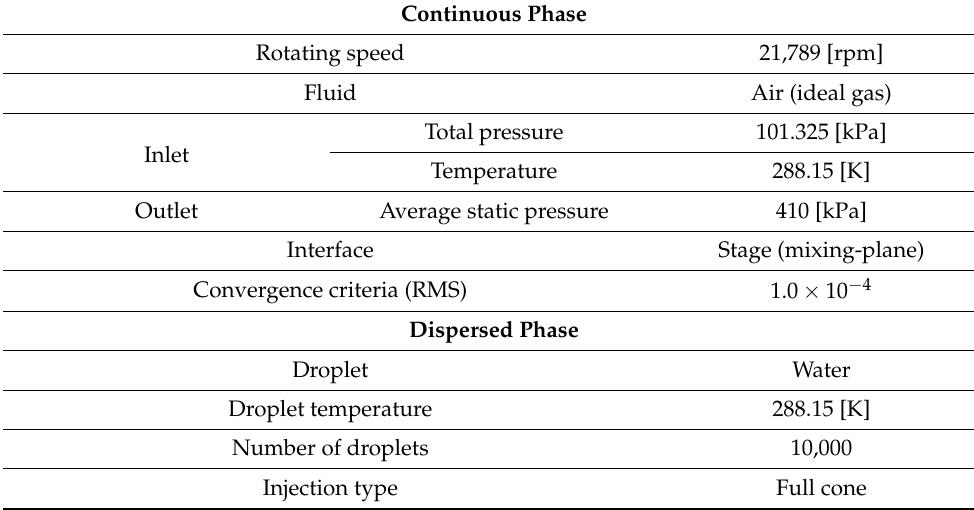
Table 2. Boundary conditions of the centrifugal